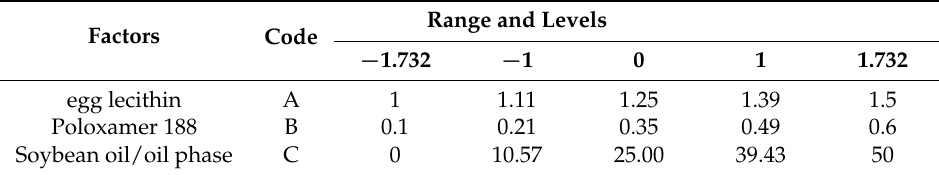
Table 1. Levels and code of variables chosen for the central composite